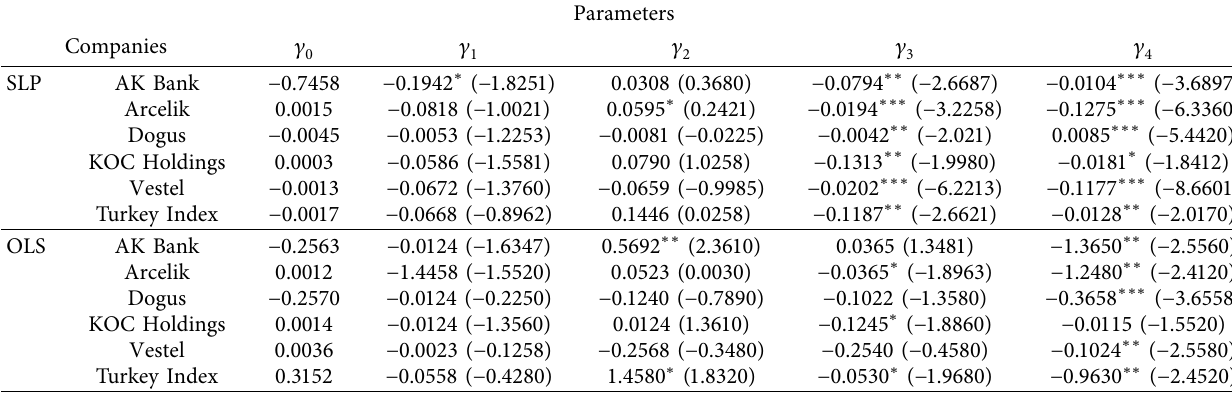
Table 8: Coefficients outputs for Turkey without sentiment.